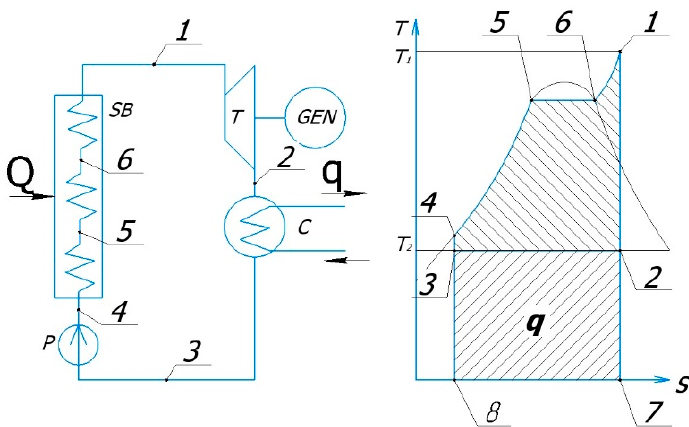
Figure 1. Scheme for generating thermal and electric power by means of a micro-turbine operating in the Rankine cycle with superheated steam. SB —steam boiler; T —steam turbine; GEN —electric generator; C —condenser; P —pump .